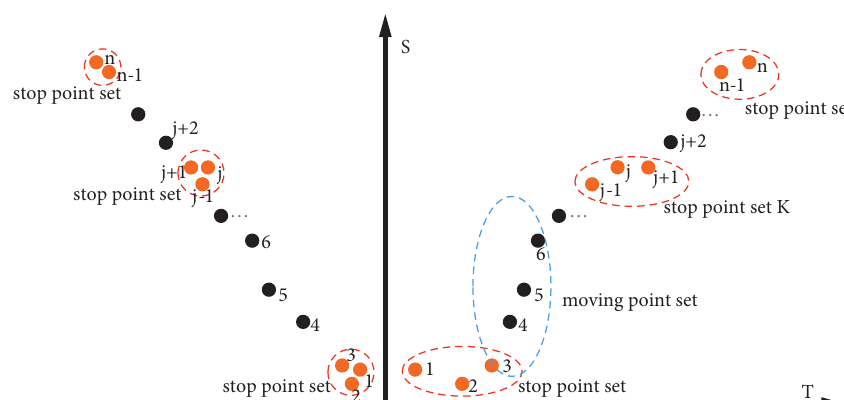
Figure 4: Movement of passengers after leaving the station.